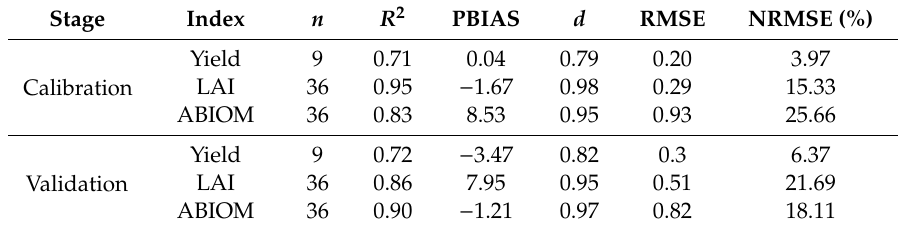
Table 4. Summary statistics of calibration and validation results for pod yield, leaf area index (LAI), and above-ground plant material (ABIOM).